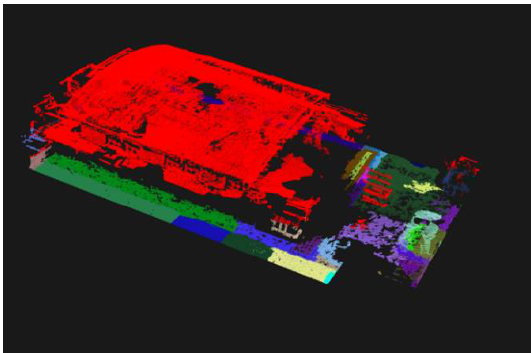
Figure 9: Region-Growing Segmentation result